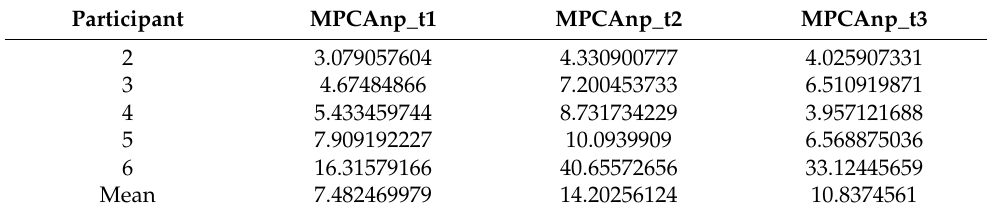
Table 23. MPCAn, pudding 10 mL (%C2–42) individual and mean measurements at three assessment time points.